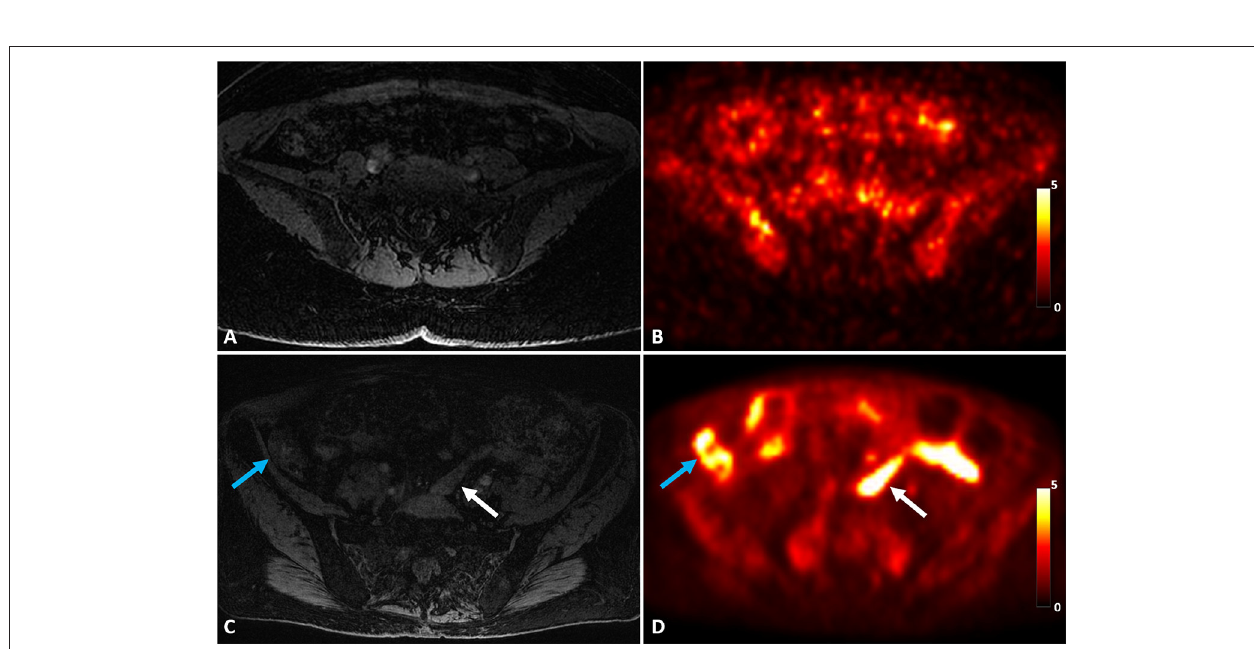
FIGURE 3 | A representative control case of MRI (A) and S1R PET (B) of a healthy control in comparison with abnormal pelvic bowel uptake of Patient 2 on MRI (C) and S1R PET (D) . Increased S1R tracer uptake was identified throughout the bowel, including both within the bowel (white arrow) and around the bowel (blue arrow). The PET images were plotted in the unit of